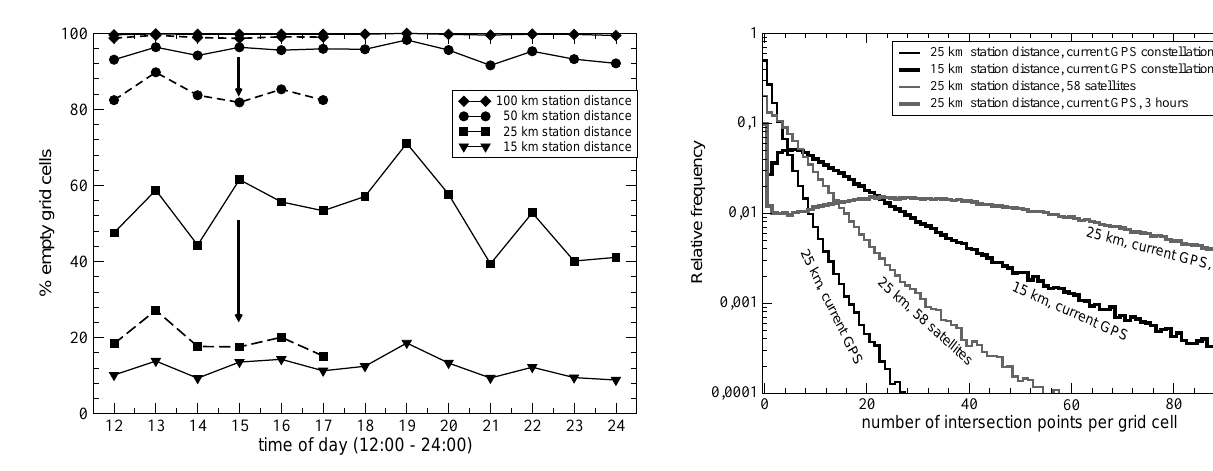
Fig. 5. Number of “empty” cells in a 15 × 15 × 0 . 5km grid for net- works with different densities of stations. The data have been com- puted for the currently available GPS satellites (solid lines) and for a situation with a doubled number of satellites (dashed lines).